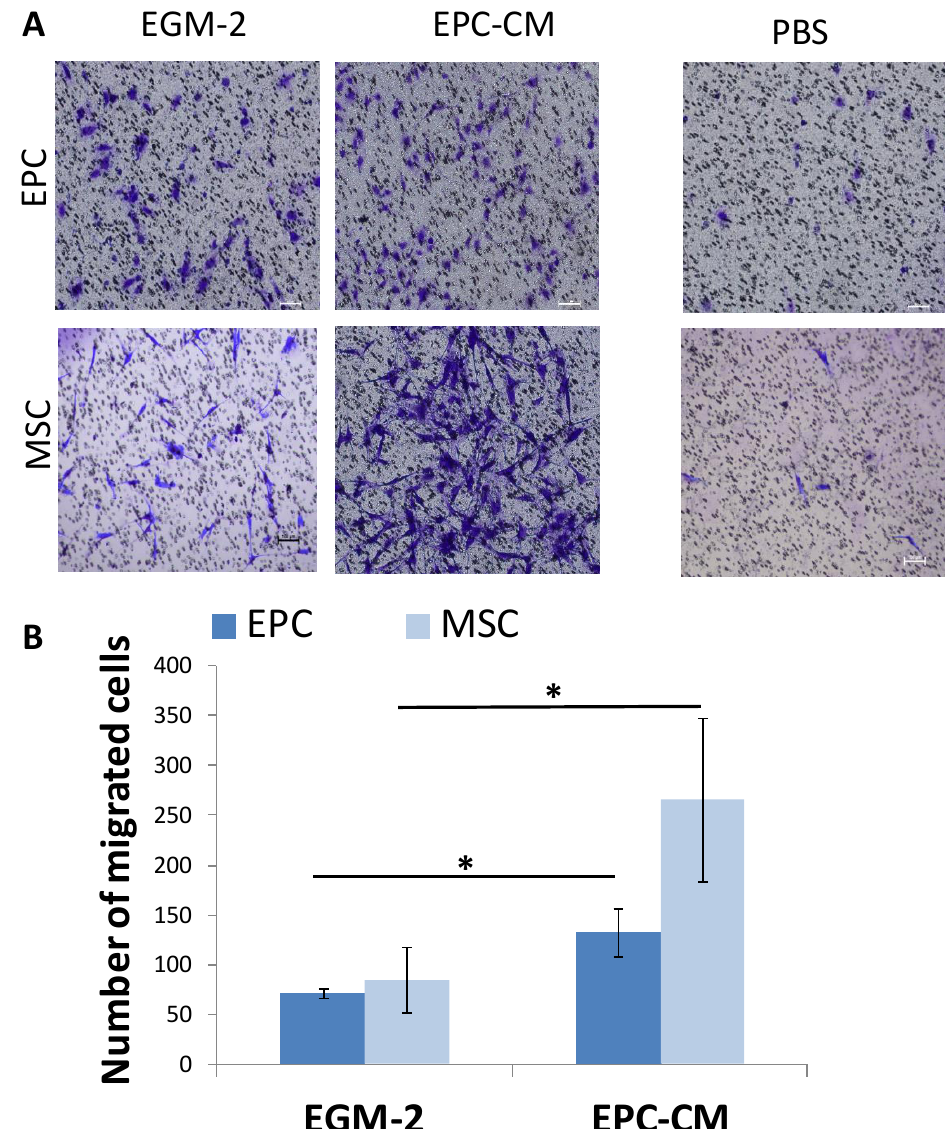
Figure 4. EPC-CM stimulate migration of MSC and EPC in Vitro. ( A ) Migration of EPCs and MSCs towards EPC-CM was evaluated in a transwell migration assay. For negative control, the lower chambers were filled with PBS. Scale = 100 µ m. ( B ) Number of migrated MSCs and EPCs towards EPC-CM or EGM-2, * p < 0.05.